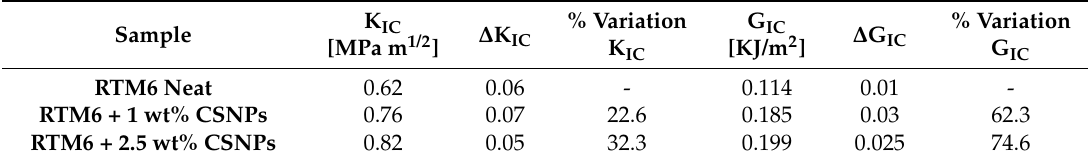
Figure 12. K IC and G IC behaviors obtained from fracture toughness tests for neat and filled systems. Table 4. Effect of CSNPs content on the nanocomposites fracture toughness.